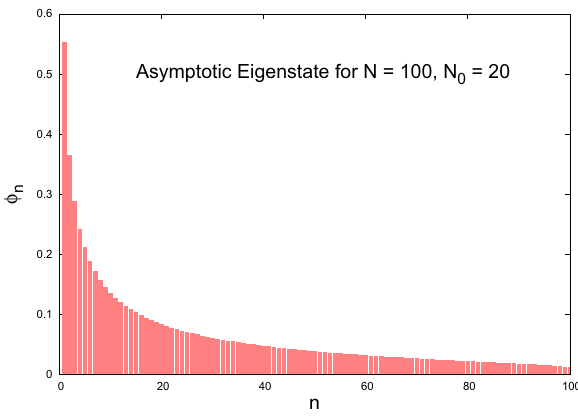
Fig. 9 The dominant eigenstate in the asymptotic α Y → ∞ region